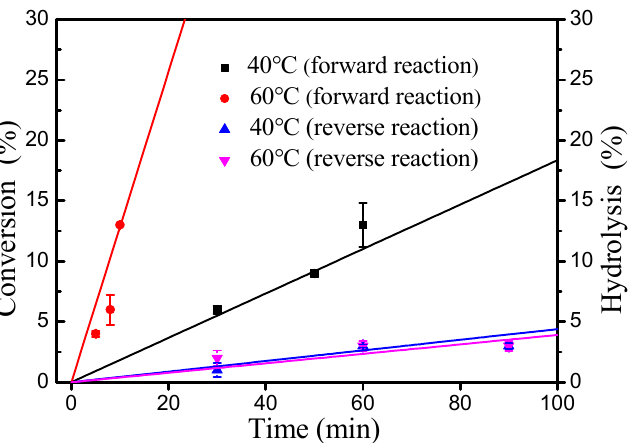
Figure 6. Initial rates of esterification of oleic acid with DBSA as catalyst for the forward and reverse reactions in water. Reaction conditions: for the forward reaction: a molar ratio of 1.3:1 oleic acid to alcohol, 10 mol% DBSA of cetyl alcohol and 100 wt% water of cetyl alcohol; For reverse reaction: 100 wt% water of wax ester and 10 mol% DBSA of wax esters.